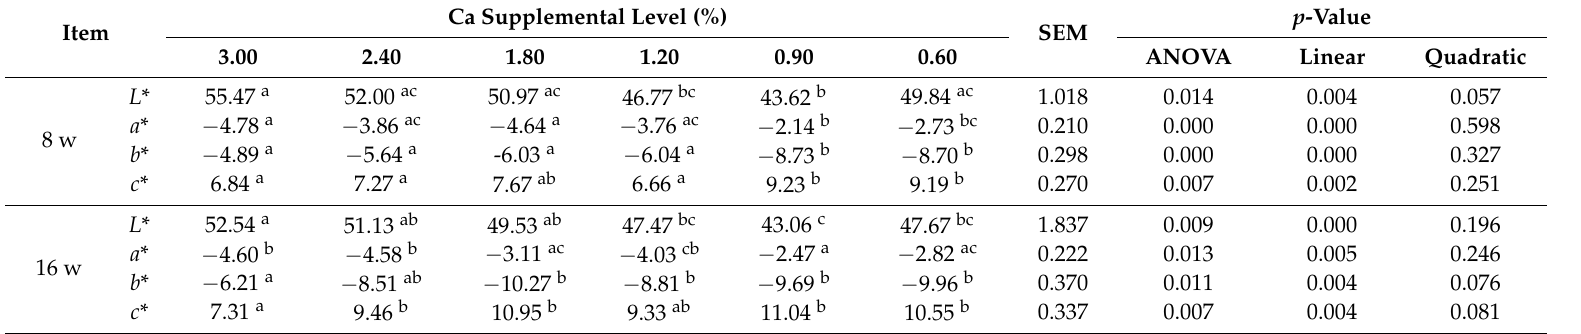
Table 4. The effect of dietary Ca level on albumen transparency of laying White King